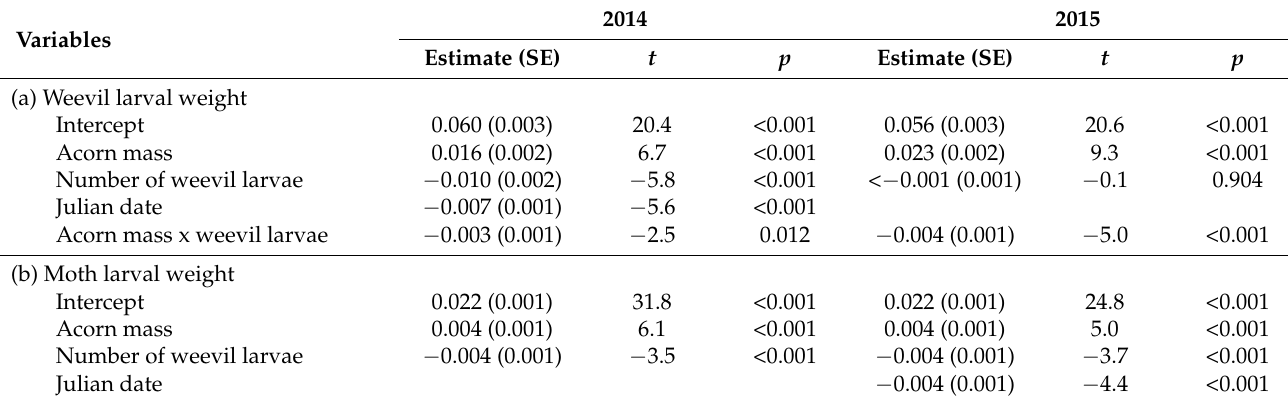
Table 2. Estimates and SE from general linear models for larval weight of weevils (a) and moths (b) developing in acorns of Quercus faginea during the 2014 and 2015 acorn